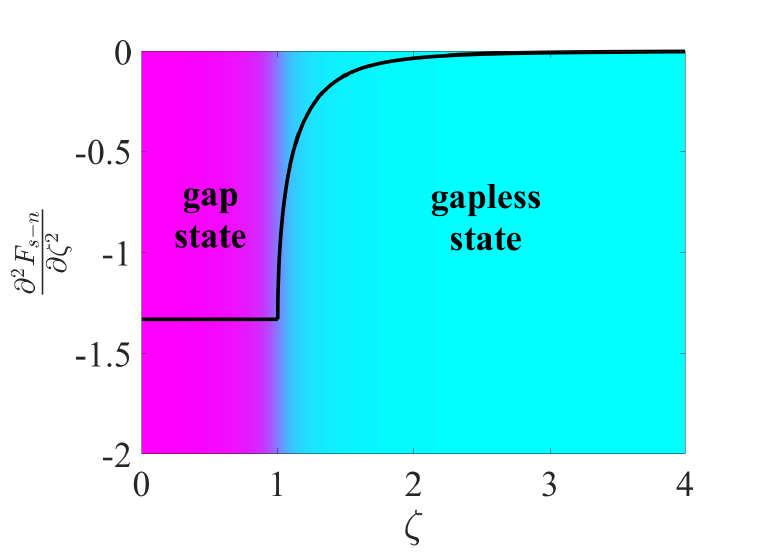
Figure 1: The second derivative of Eq. (1). The kink is clearly observed at ζ = 1. Purple and cyan colors in the background of the plot illustrate separation between gap and gapless states respectively. Weak blur near ζ = 1 represents smearing of the transition due to spacial fluctuations of the magnetic impurities concentration (see the corresponding section of the